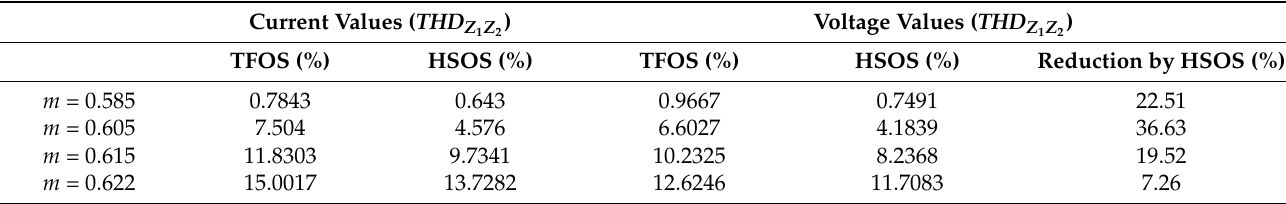
of the two 1 Z 2